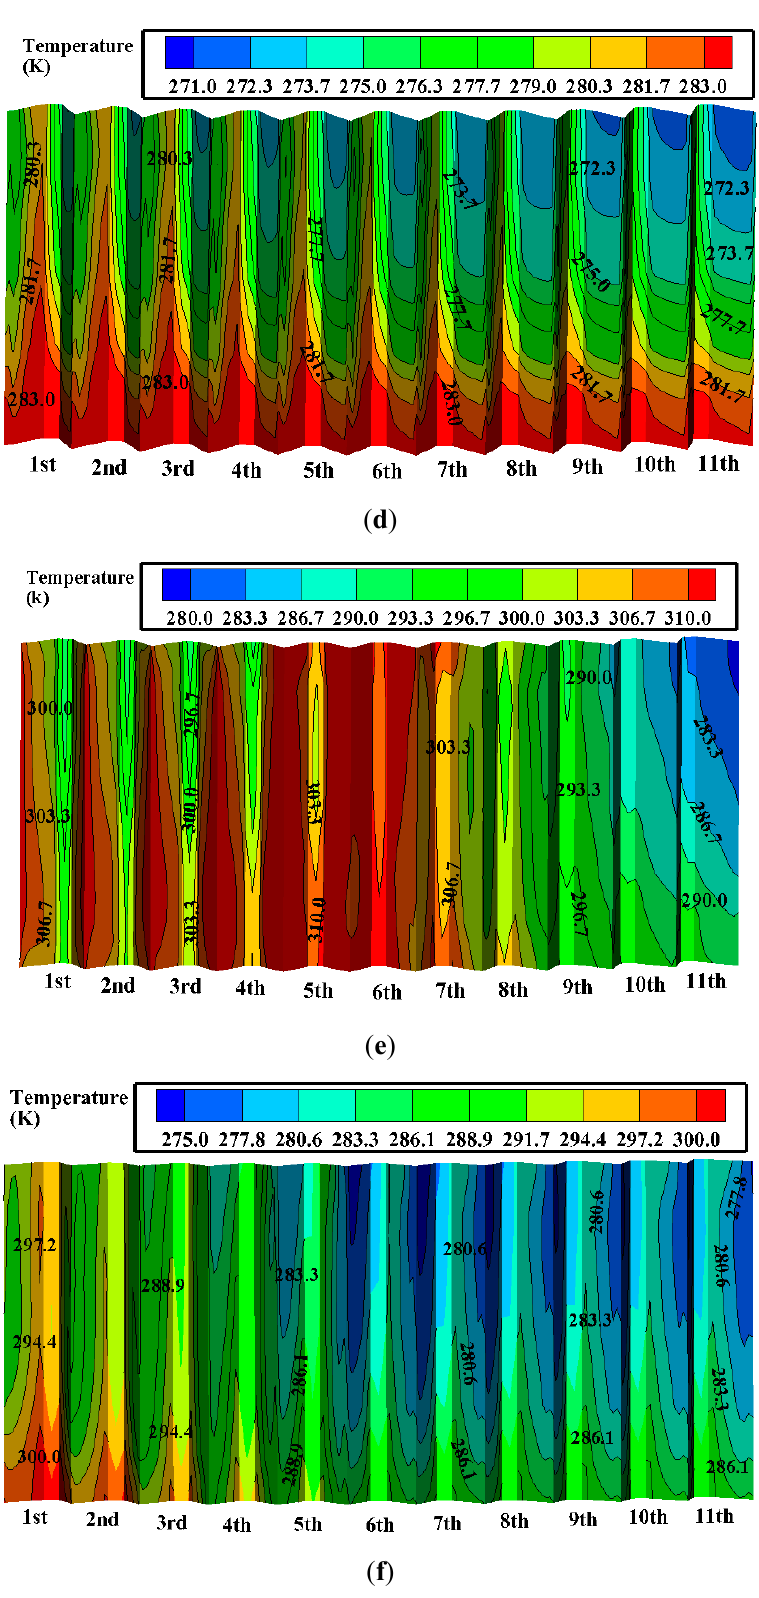
Figure 14. Variable fields of the middle-rear deltas. ( a ) Pressure and flow fields at 4 m/s, ( b ) pressure and flow fields at 12 m/s, ( c ) pressure and flow fields at 16 m/s, ( d ) outlet air temperature at 4 m/s, ( e ) outlet air temperature at 12 m/s, ( f ) outlet air temperature at 16